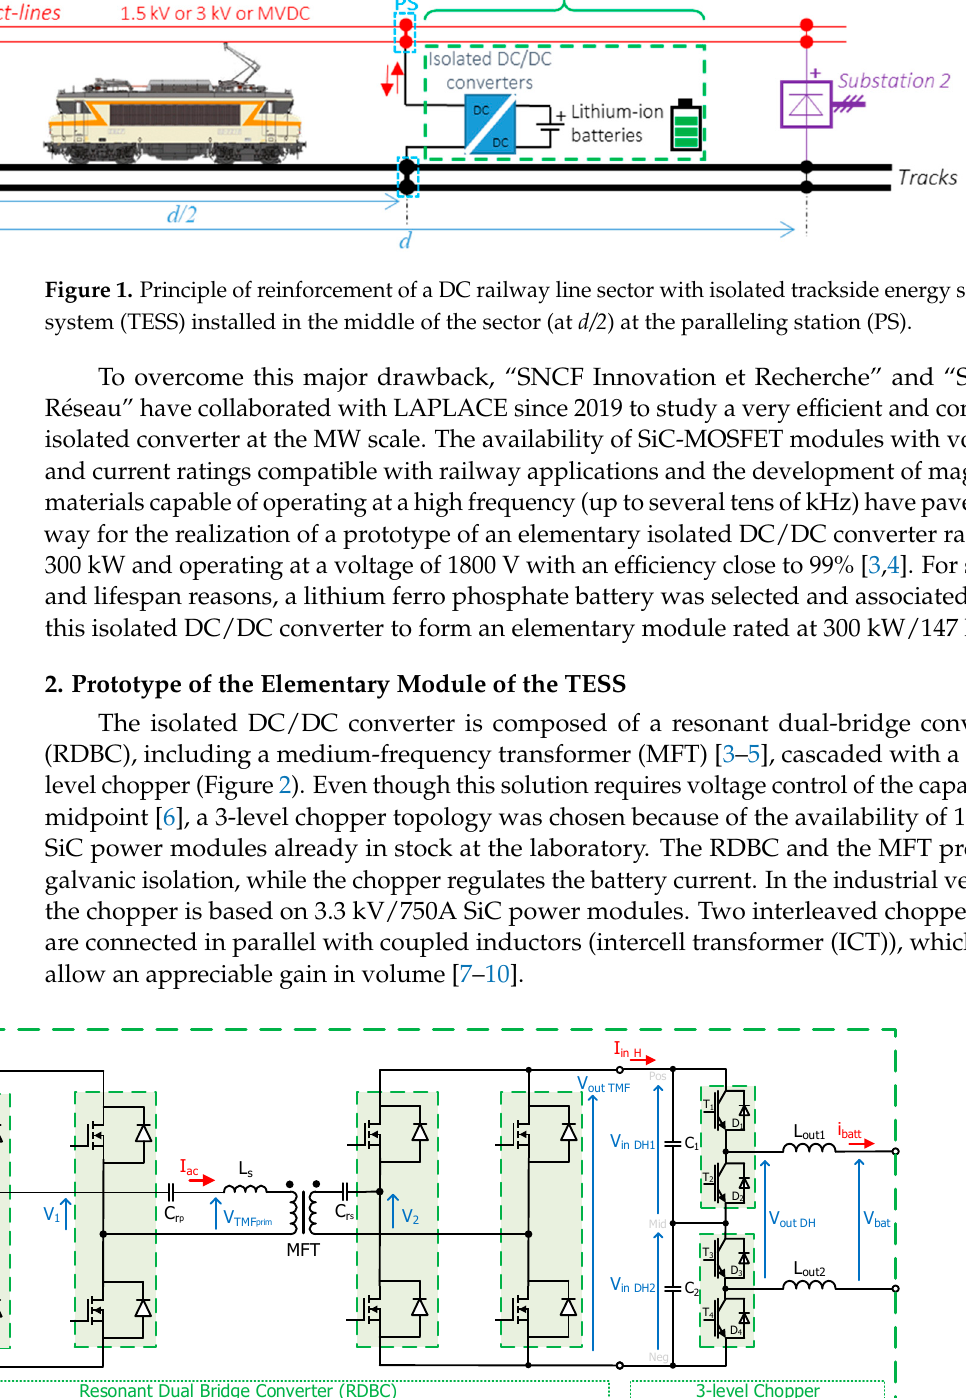
Figure 3. Paralleling principle for reinforcing a DC railway line sector with N elementary isolated trackside energy storage systems. Table 1. Isolated DC/DC converter prototype: RDBC DCM and 3-level chopper speci fi cations. RDBC DCM